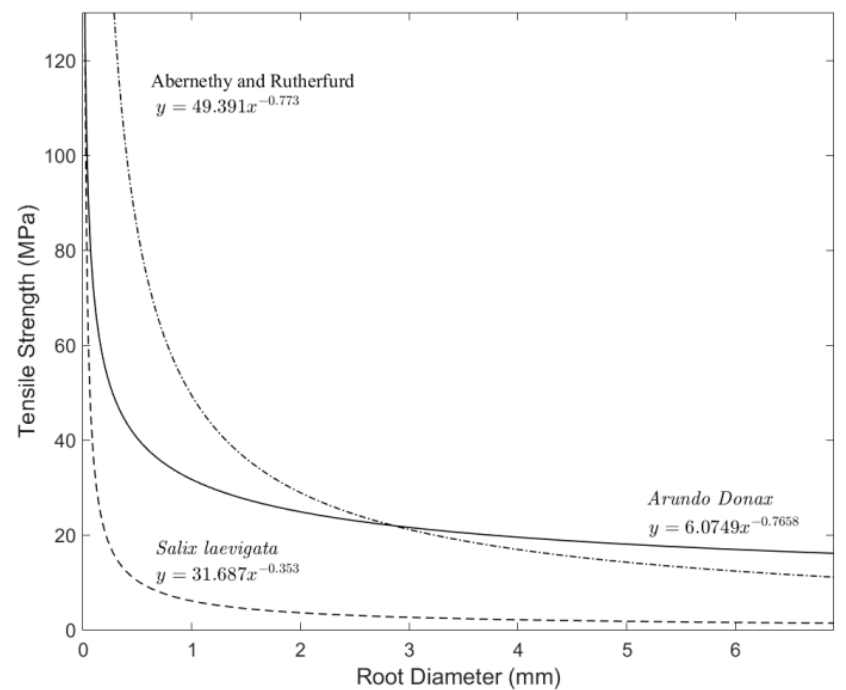
Figure 15. Comparison of tensile strength and root diameter relationship to the relationship found [24] for two large Australian trees, Red River Gum and Swamp Paperbark to those found in this study for A. donax and S. laevigata.